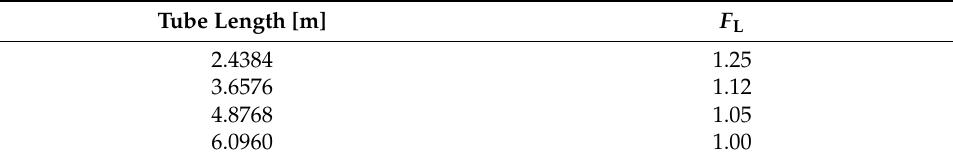
Table 3. Length factor with respect to different tube lengths [36].